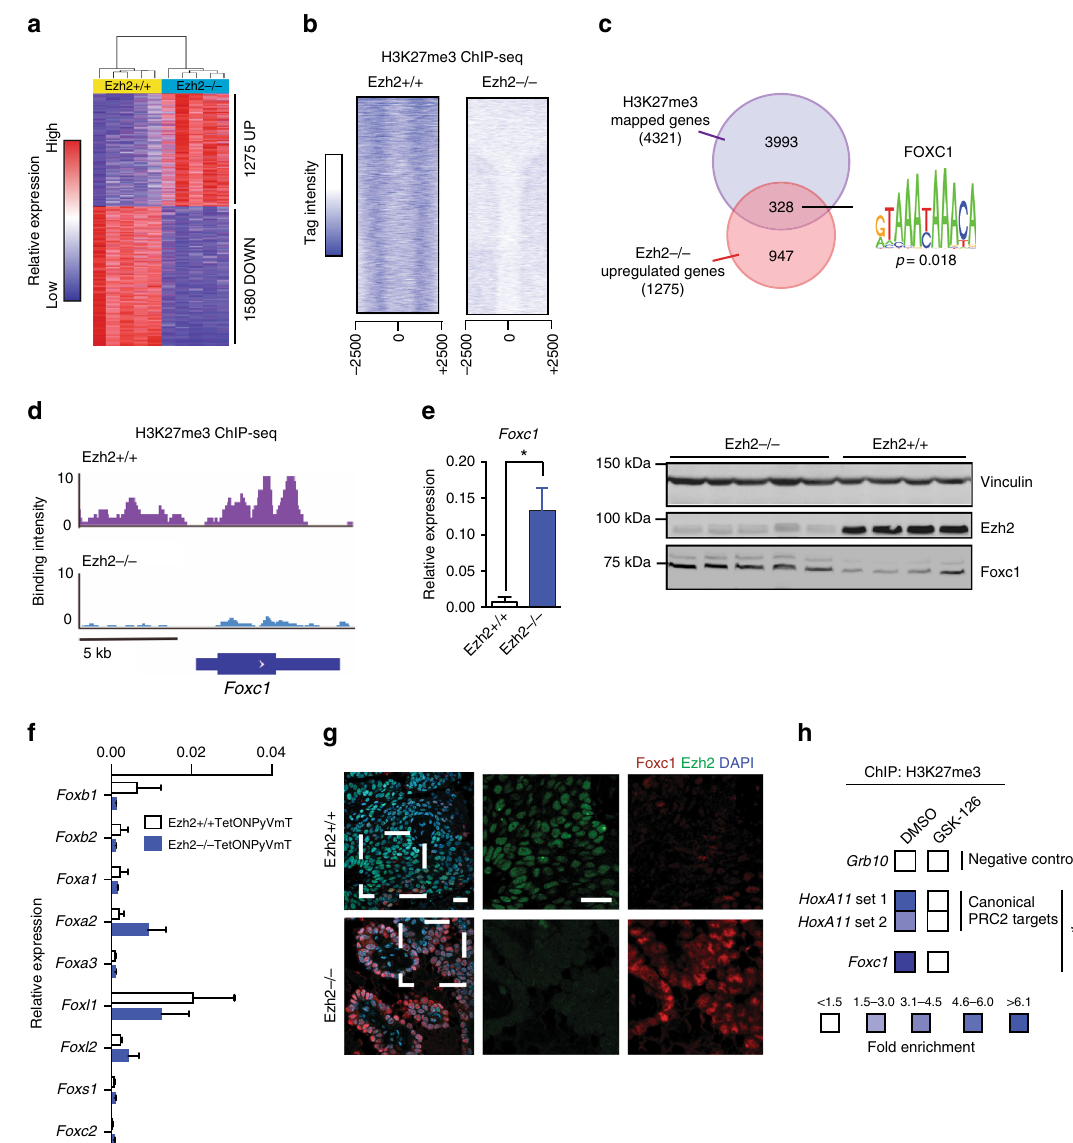
Fig. 3 De-repression of Foxc1 following Ezh2 inhibition. a Hierarchical clustering of genes differentially expressed between Ezh2 + / + and Ezh2 − / − Tet-ON PyVmt tumours ( n = 5) using p < 0.05 and fold change > 1.5 cutoff. Red and blue indicate high and low expression of genes, respectively. b Heatmaps of signal intensity illustrating H3K27me3 ChIP-seq genomic mapping in a window of ±2.5 kb identi fi ed in Ezh2 + / + and Ezh2 − / − Tet-ON PyVmt tumours. c Overlap between differentially upregulated genes in Ezh2 − / − endpoint Tet-ON PyVmT tumours and genes identi fi ed by ChIP-seq to be targeted by H3K27me3. d Differential H3K27me3 levels in the upstream promoter region of Foxc1 in Ezh2 + / + vs. Ezh2 − / − endpoint Tet-On PyVmT tumours. Image from the IGV browser. e Left- Signi fi cant upregulation of Foxc1 mRNA in Ezh2 − / − Tet-ON PyVmT endpoint tumours compared to wild-type tumours. Right- Immunoblot of Ezh2 + / + or Ezh2 − / − Tet-ON PyVmT endpoint tumours for Foxc1 and Ezh2 levels. Vinculin loading control. * p < 0.05, two tailed t - test. f qRT-PCR screen of Forkhead box family members in tumours lacking Ezh2. g Immuno fl uorescence staining of Foxc1 and Ezh2 in endpoint Ezh2 + / + or Ezh2 − / − Tet-ON PyVmT tumours. Scale bars are 50 μ m. h Chromatin immunoprecipitation enrichment of H3K27me3 at canonical PRC2 targets and the Foxc1 promoter in DMSO treated PyVmT cells which is lost in GSK-126 treated cells. * p < 0.05, two tailed t